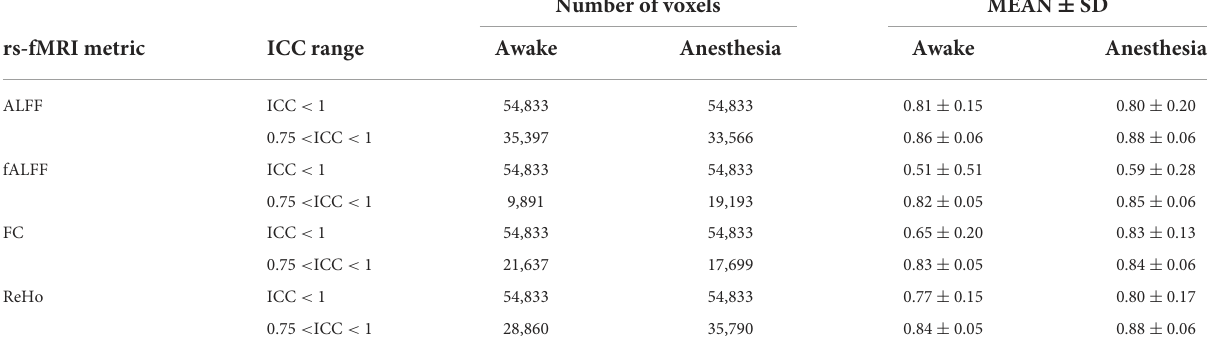
TABLE 1 Mean ± SD and number of voxels of ICC of rs-fMRI metrics including the amplitude of low-frequency fluctuation (ALFF), fractional amplitude of low-frequency fluctuation (fALFF), functional connectivity (FC), and regional homogeneity (ReHo) in two different masks where ICC < 1 and 0.75 < ICC < 1 in two states of awake and under